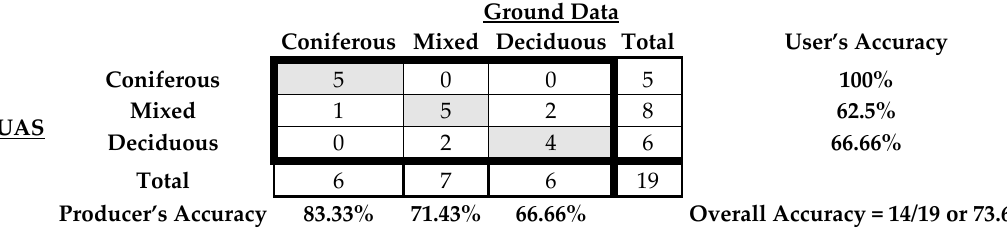
Table 4. CFI plot-registered PBC thematic map error matrix. Ground (reference) data are represented by the CFI plots and Unmanned Aerial Systems (UAS) data are derived from the corresponding orthomosaic.